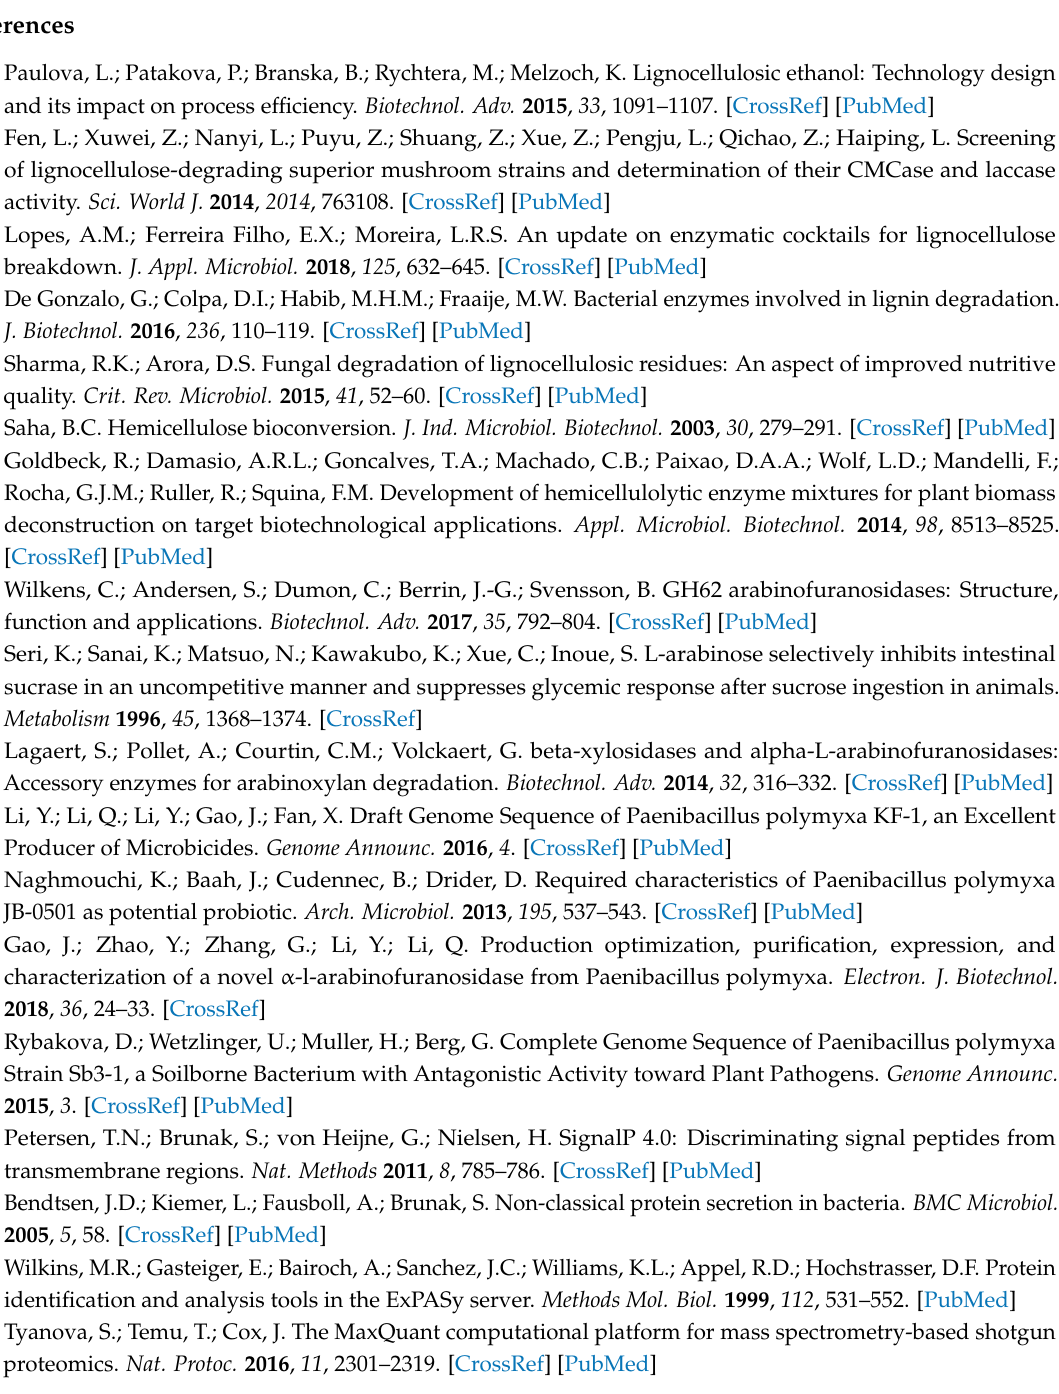
Table S1: Other carbohydrate degrading enzymes identified by LC-MS/MS from P. polymyxa ; Table S2: Other predicted hemicellulose-degrading enzymes in the genome sequence of P. polymyxa